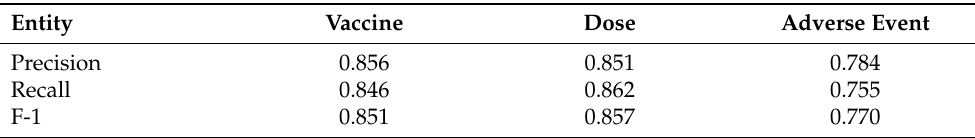
Table 2. Performance of the named entity recognition through the Conditional Random Fields (CRF) algorithm provided by